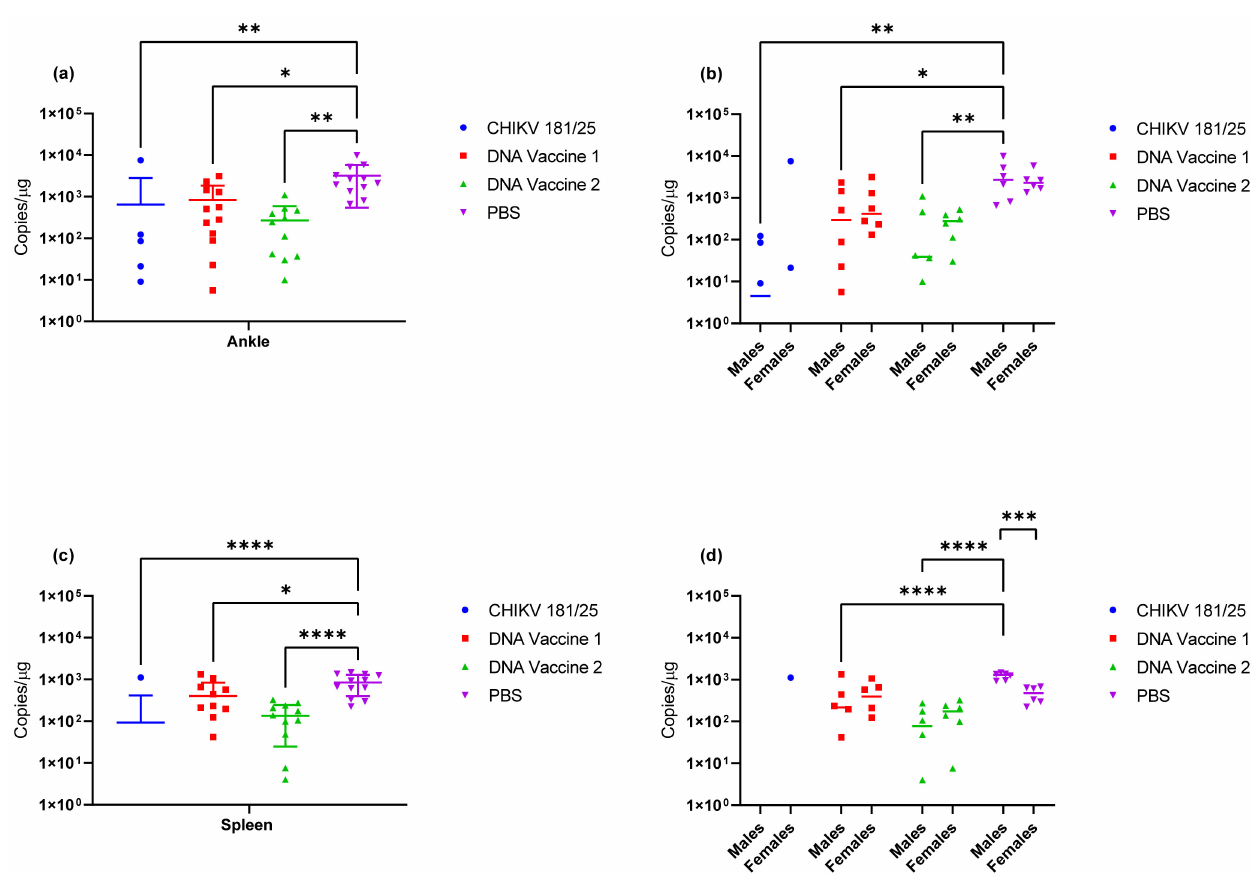
Figure 11. Viral RNA concentration in tissues collected on day 9 post-challenge. ( a ) Viral RNA copy number in the left ankle of vaccinated versus unvaccinated animals. ( b ) Viral RNA copy number in the left ankle of male versus female animals. ( c ) Viral RNA copy number in the spleen. ( d ) Viral RNA copy number in the spleen of male versus female animals * p < 0.05, ** p < 0.005, *** p < 0.0008, **** p <